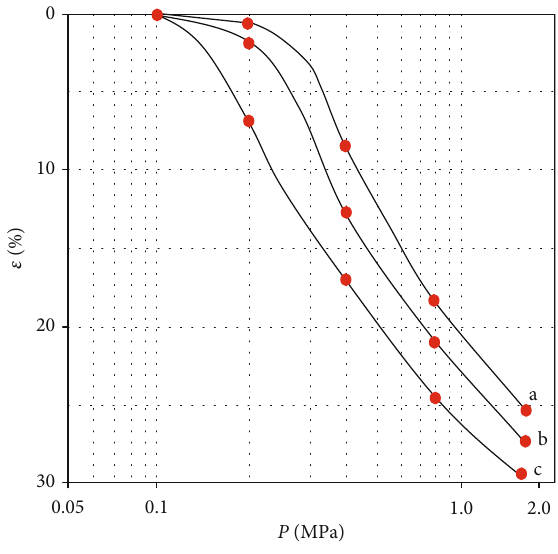
Figure 2: Equitime e − lg p